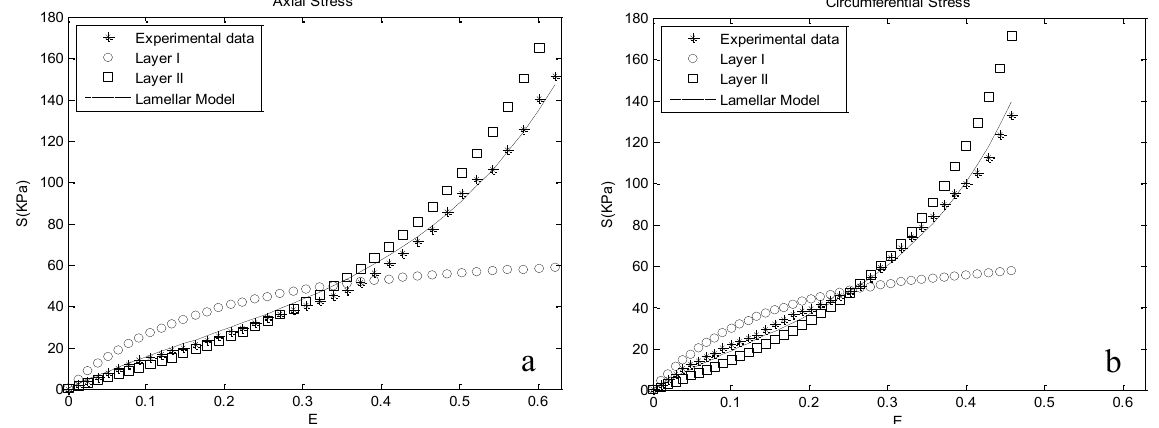
Figure 4. Experimental stresses plotted together with computational stresses for M25 (male donor, aged 25), based on the evaluated material parameters. The contribution of Layers I and II on the mechanical behavior of the media is depicted, as well, for the range of experimental strains: ( a ) axial direction; ( b ) circumferential